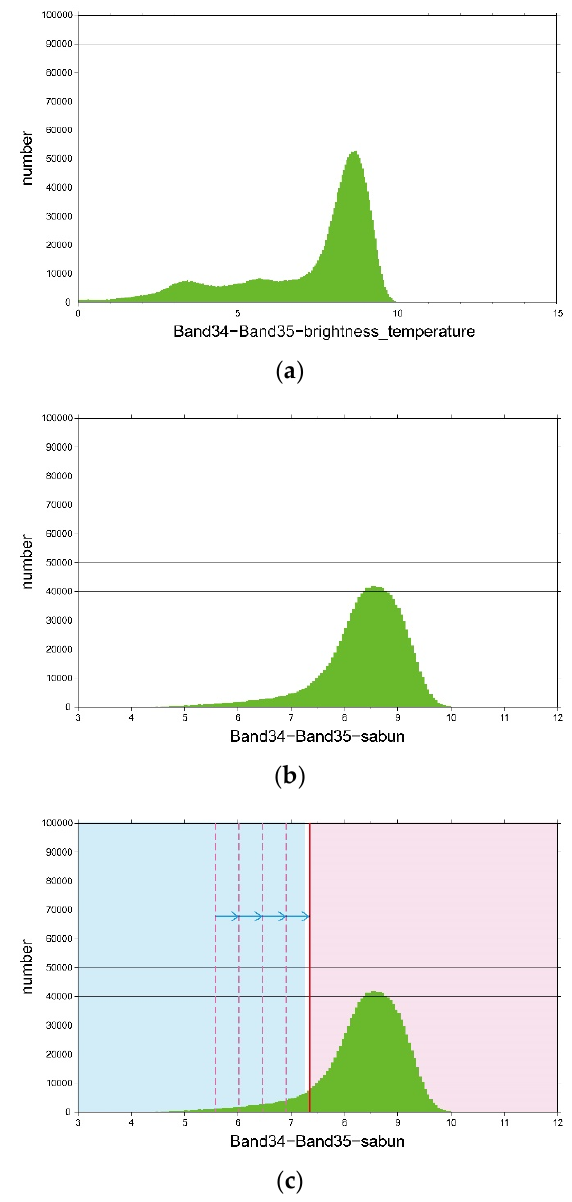
Figure 5. Distributions of the brightness temperature difference (BTD) between band 34 and band 35 in October at Shinmoedake. ( a ) Original distribution of BTD 34–35 . The distribution seems to be composed of multiple normal distributions; ( b ) BTD 34–35 distribution after Test 1. Cloud pixels determined by Test 1 are removed; ( c ) schematic image of the repeat of the cloud reduction process. A new average value µ′ and standard deviation σ′ are calculated from the remaining data, and pixels that do not satisfy the formula are rejected. Finally, pixels in the red area are fixed as clear and the blue region rejected as clouds.